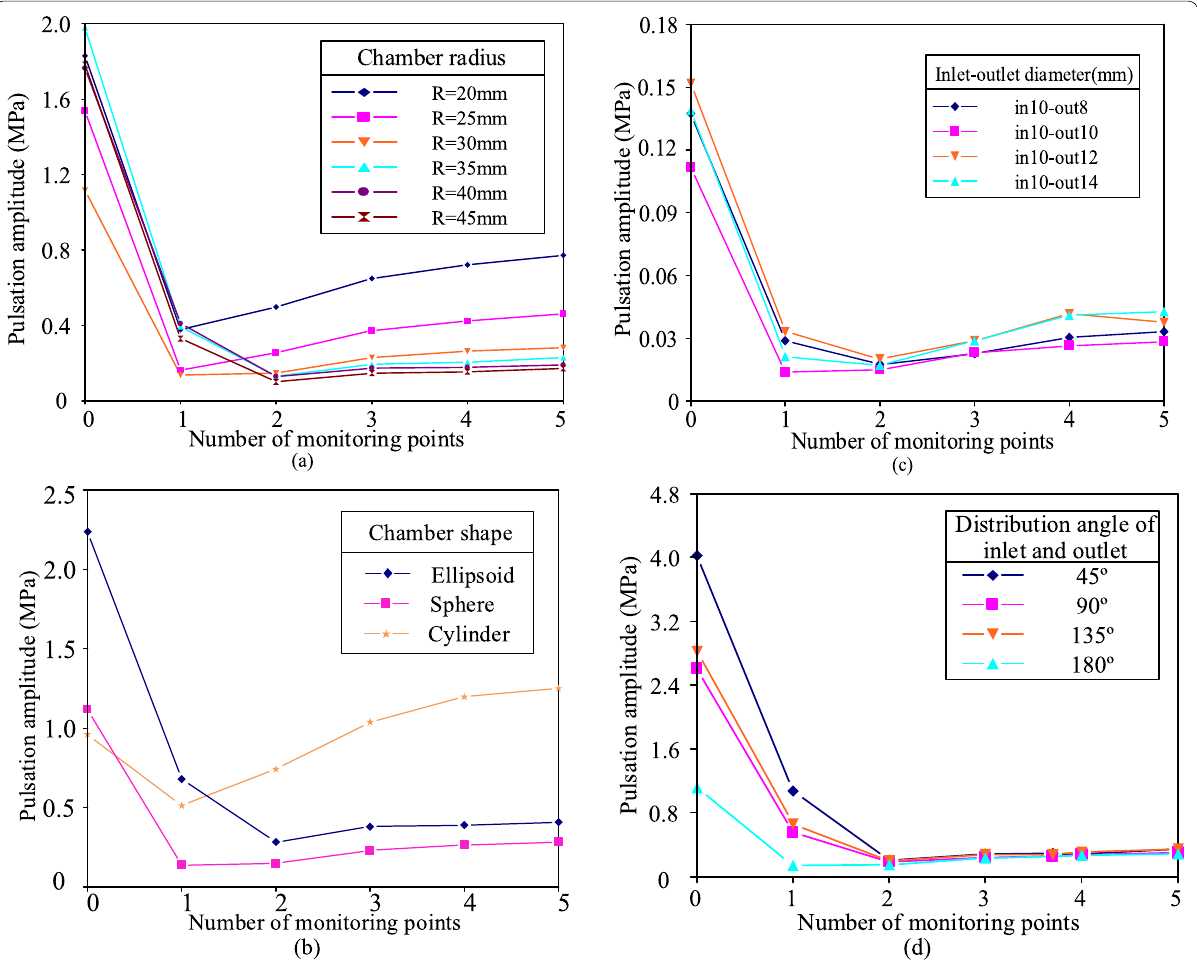
Figure 31 Effects of different factors on pulsation attenuator: a chamber radius, b chamber shape, c inlet-outlet diameter, d distribution angle of inlet and outlet